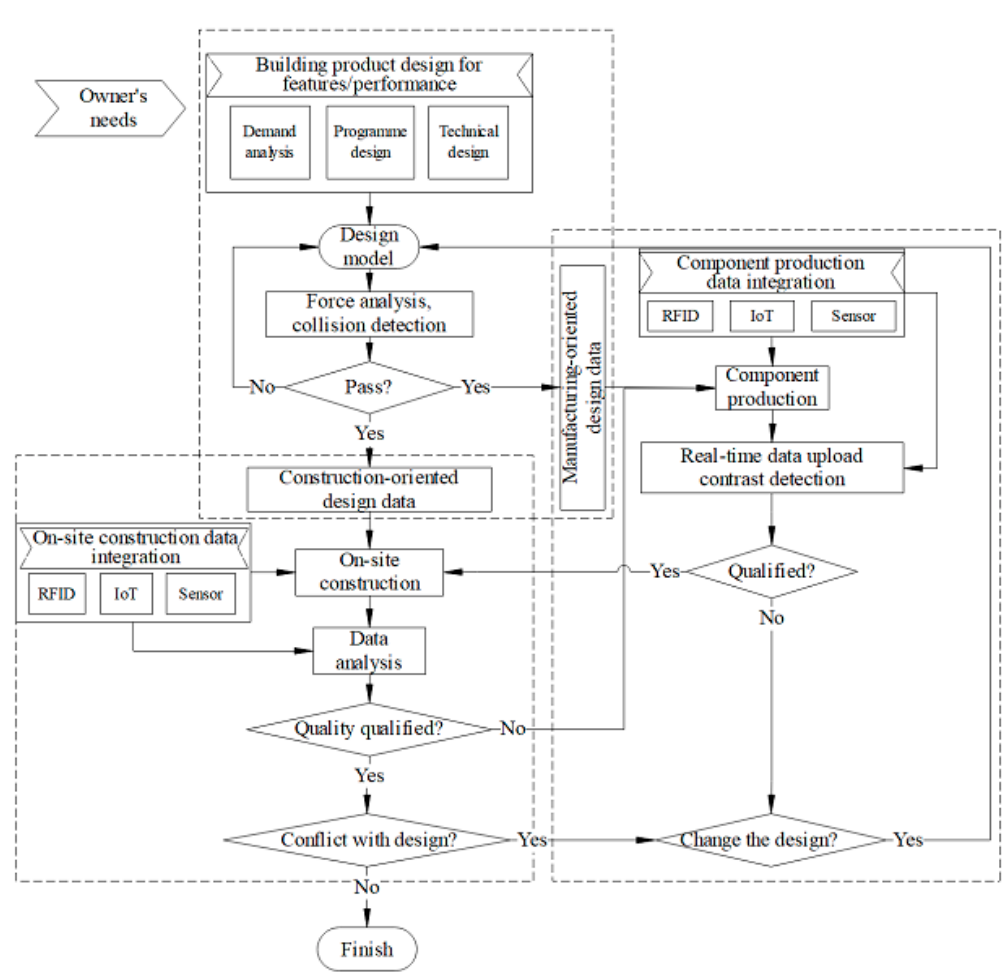
Figure 3. The operating mechanism of ICSPB-IoT in the design stage.